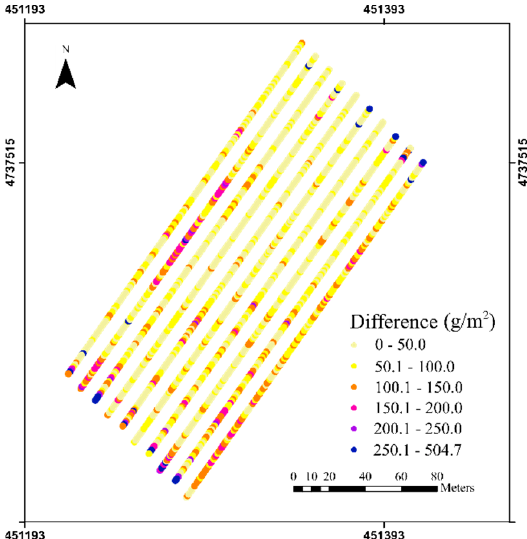
Figure 13. Absolute difference map between the harvester measured grain yield and the estimated yield for S2.